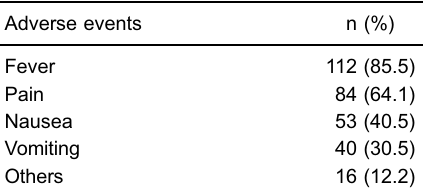
Table 3. Adverse events one week after drug- eluting bead transarterial chemoembolization treat- ment in hepatocellular carcinoma patients (131